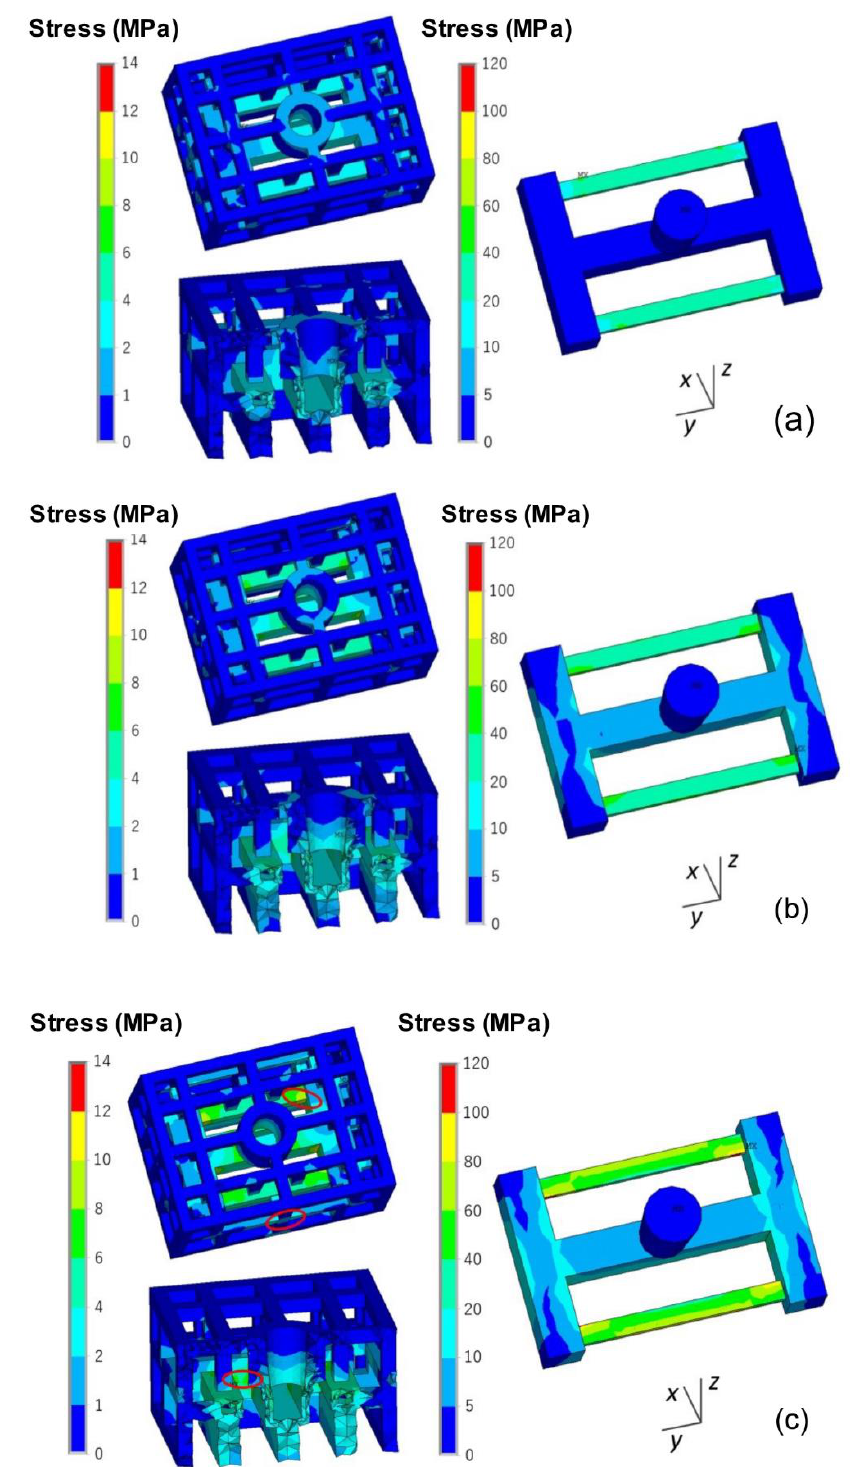
Figure 13. von Mises stress field of skeletal sand mold and casting: ( a ) 500 s; ( b ) 1500 s and ( c ) 4500 s. The stress mainly evolved from the thin bars of the casting and then expanded to the whole casting, reaching a maximum of 80 MPa at the joints of the thin bars and beam. For the sand mold, the high-stress areas were mainly in the shell; the average level was approximately 2 MPa, and the highest value reached 12 MPa at the corner area corresponding to the beam and thick and thin bars.